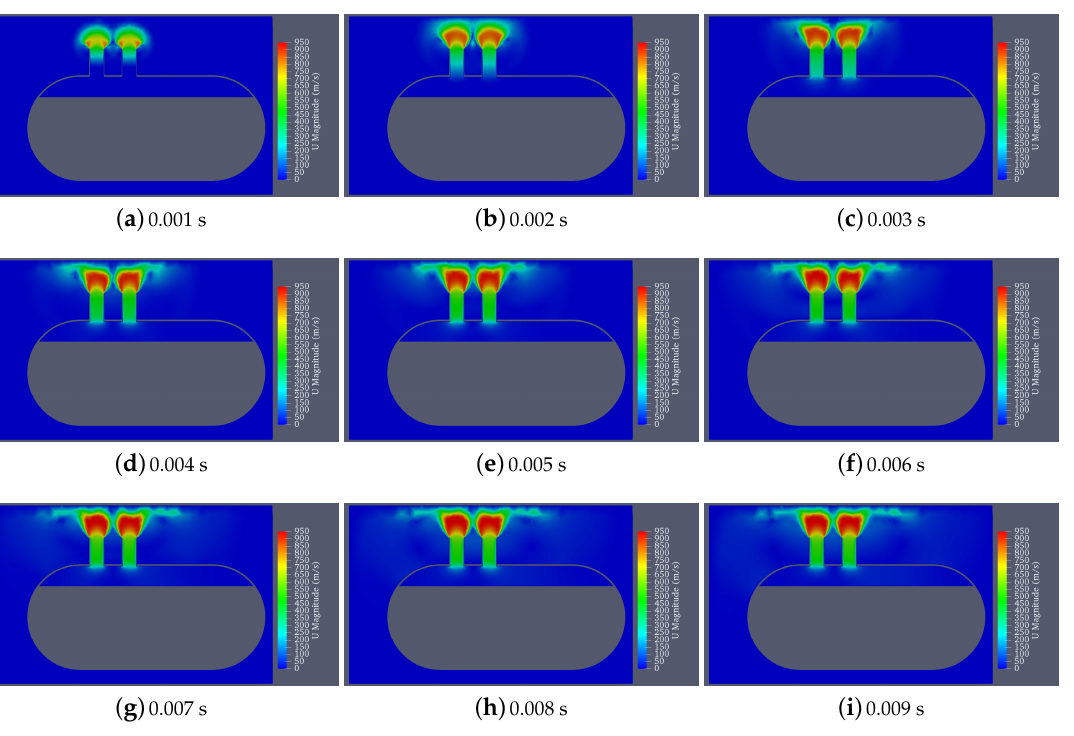
Figure 12. The distribution of velocity of the simulation results of the SST k - ω model by using PRTFOAM at different times from ( a ) 0.001 s to ( i ) 0.009 s with interval ∆ t = 0.001 s (legend unit: